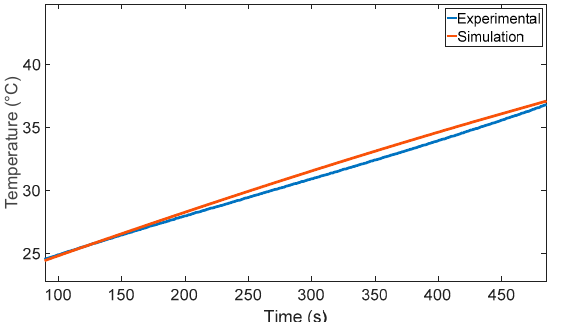
Figure 12. Experimental temperature results and temperature simulation for 45 A discharge process.